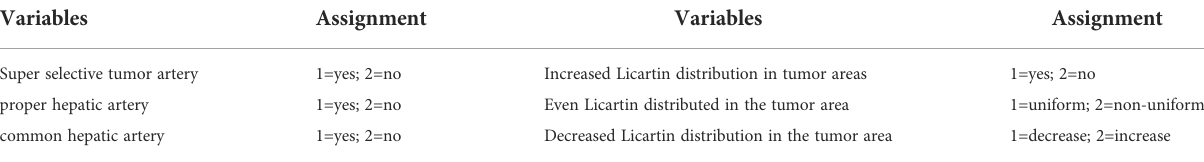
TABLE 5 Distribution analysis of injected arterial variables affecting the regional distribution of Licartin in liver malignant tumors. Variables